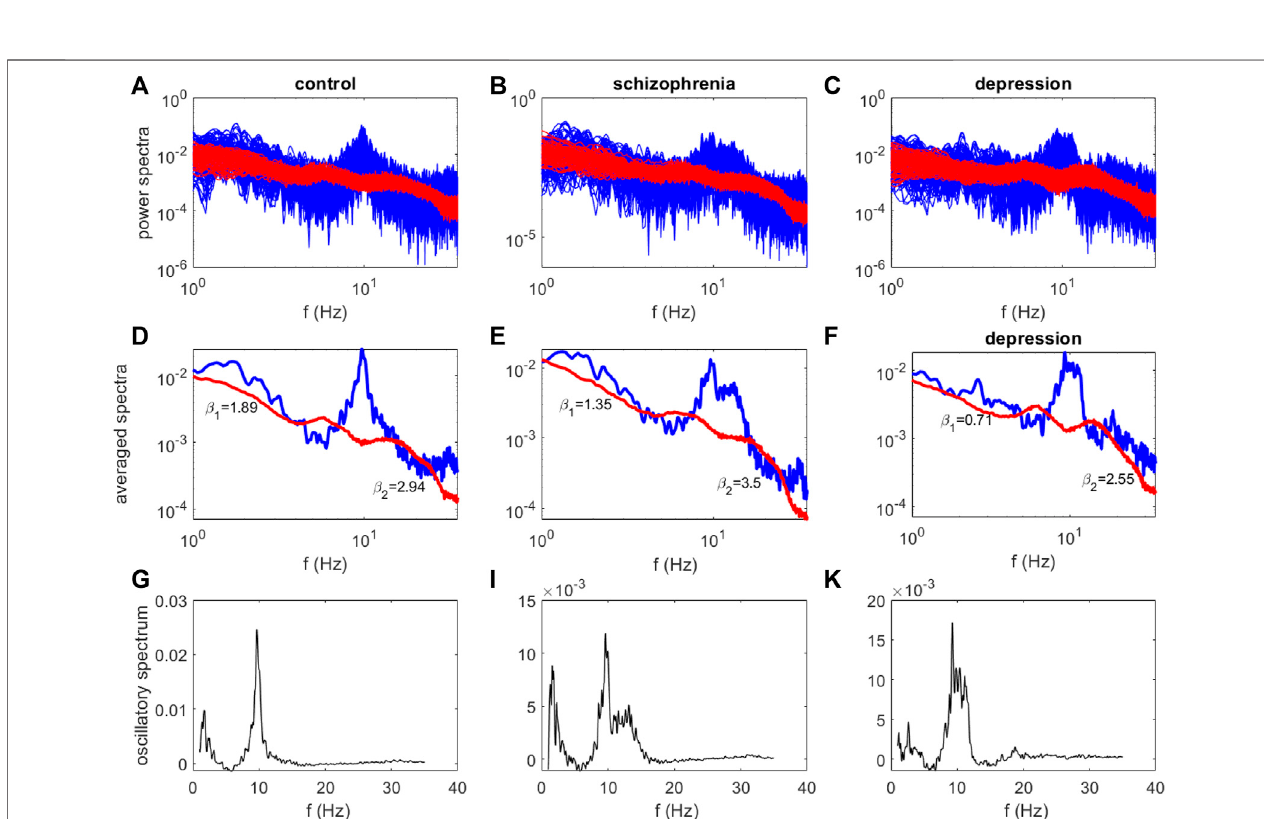
FIGURE2| Theexamplesofpowerspectraforthehealthysubject (A,D,G) ,thepatientwithschizophrenia (B,E,I) andthepatientwithdepression (C,F,K) (O2site). The original (mixed) power spectra are marked in blue, the fractal components - in red (A – C) . The averaged mixed and fractal power spectra (D – F) , the oscillatory spectra (G – K) .